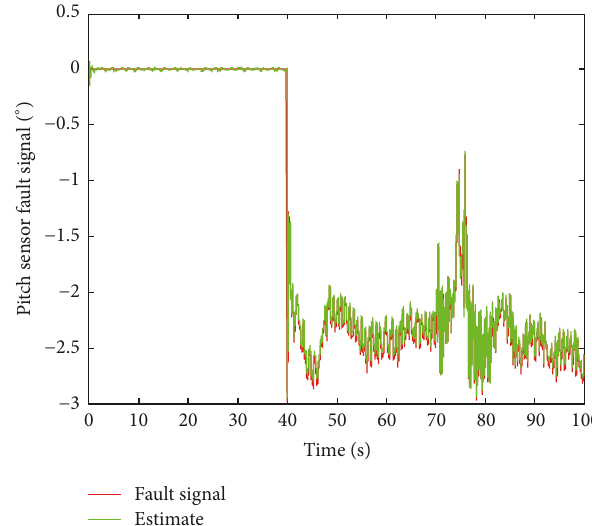
Figure 4: Pitch sensor fault and its estimate with 𝑓 𝑠 = − 0.2.